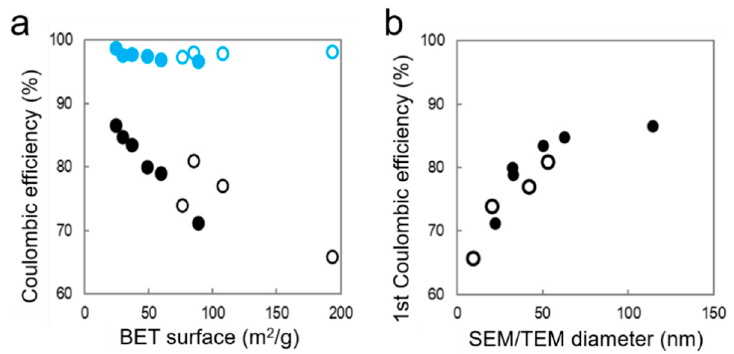
Figure 6. Coulombic efficiency as a function of BET specific area ( a ) and statistical SEM/TEM diameter ( b ) for SiNPs (full circles) and SiNWs (empty circles) on the 1st cycle (black) and the 5th cycle (blue).